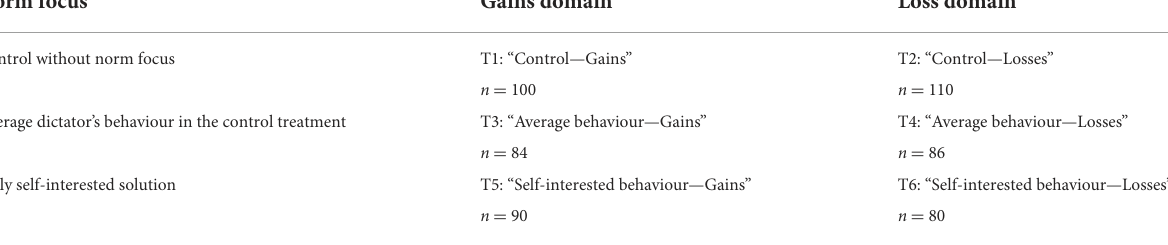
TABLE 1 Overview of